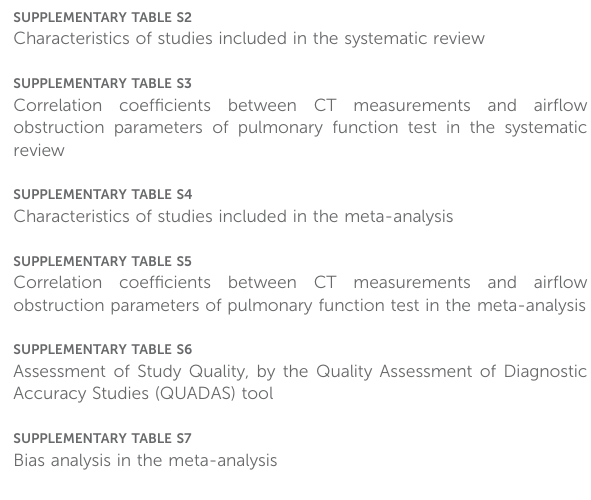
Accuracy Studies (QUADAS) tool SUPPLEMENTARY TABLE S7 Bias analysis in the